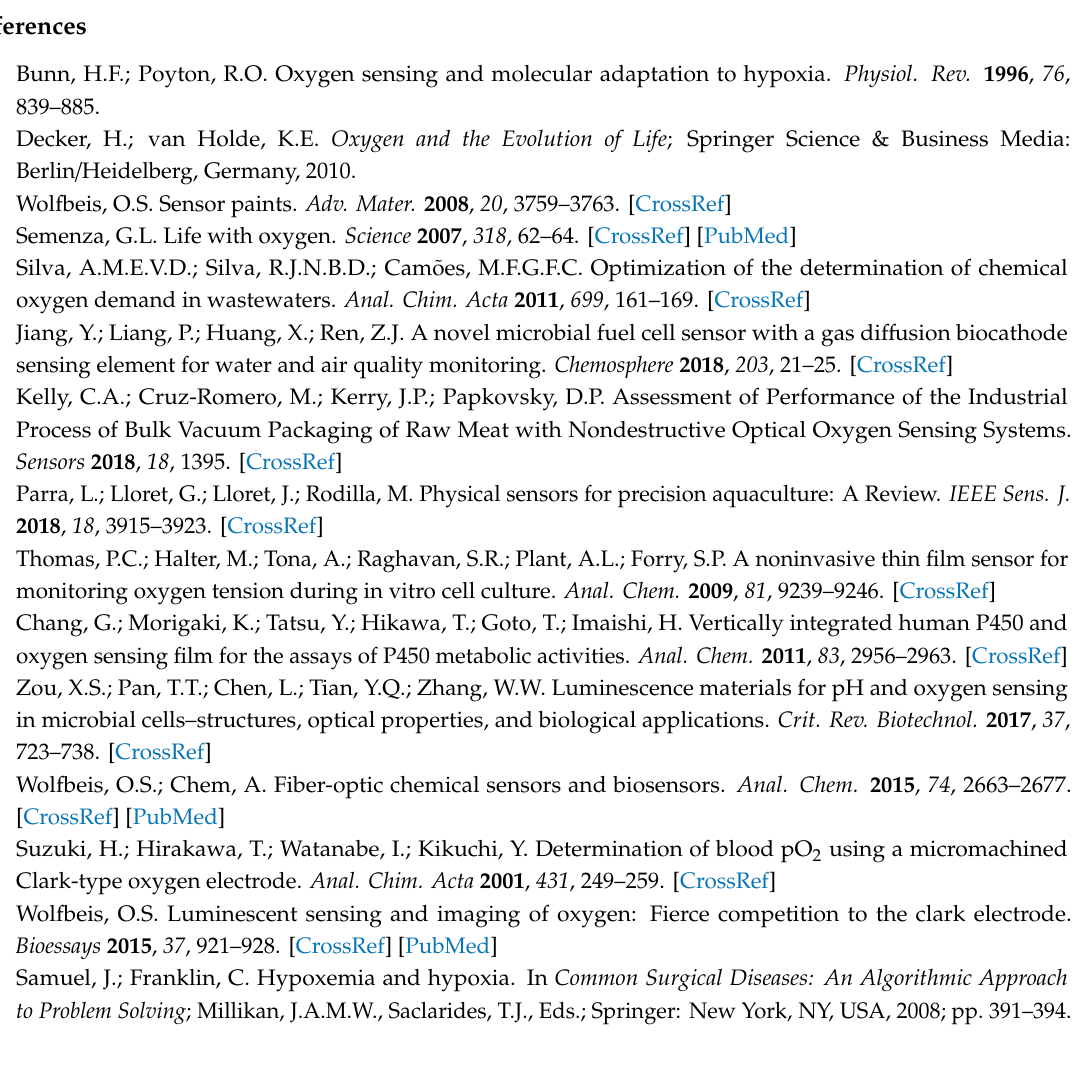
Figure S1: Stability of M1–M3 at 4 ◦ C with PtTFPP determined by size changes, Figure S2: Critical Micelle Concentrations (CMC) of the polymers P1 ( A ), P2 ( B ), and P3 ( C ), Figure S3: Oxygen consumption of E. coli JM109 monitored with micelles M1 – M3 without oil sealing. Concentrations of PtTFPP were 3 µ g / mL in each micelle. ( A , C , E ): Representative phosphorescence intensities’ changes at 650 nm with E. coli . ( B , D , F ): Relative dissolved oxygen concentration changes with E. coli . ( A , B ) are for M1 ; ( C , D ) are for M2 ; ( E , F ) are for M3